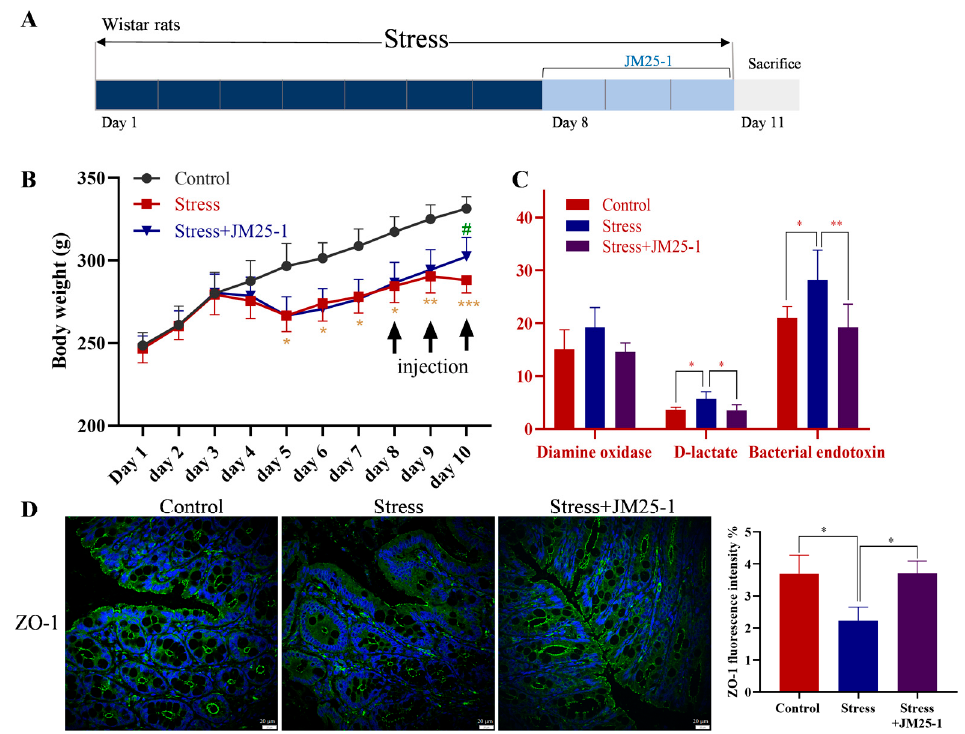
Figure 4. JM25-1 repairs intestinal permeability in stress induced rats. ( A ) Modeling method. ( B ) Body weight of rats after treatment with JM25-1 (i.p. every day, 15 mg/kg, n = 7); bar, S.D. * p ≤ 0.05, ** p ≤ 0.01, *** p ≤ 0.001 vs. the Control group. # p ≤ 0.05 vs. the Stress group ( C ) the level of diamine oxidase, D-lactic acid and bacterial endotoxin in serum on day 11. bars, S.D. * p ≤ 0.05, ** p ≤ 0.01; ( D ) immunofluorescence staining of ZO-1 in intestine. Bar = 20 µ m, magnification 200 × . bars, S.D. * p ≤ 0.05.